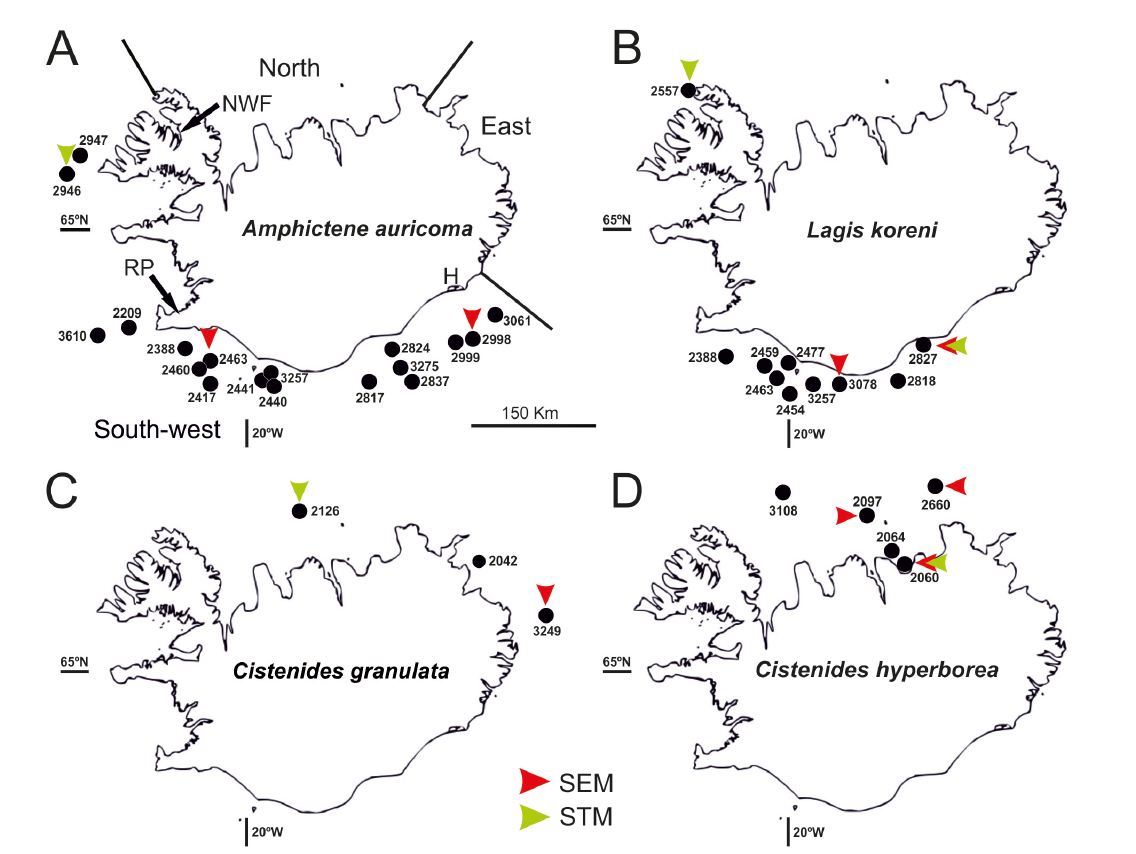
Fig. 1. Maps of Iceland showing distribution of the species of Pectinariidae found in BIOICE samples. A . Amphictene auricoma (O.F. Müller, 1776). B . Lagis koreni Malmgren, 1866. C . Cistenides granulata (Linnaeus, 1767). D . Cistenides hyperborea Malmgren, 1866. The three main coastal sectors around Iceland are shown in A. The specimens photographed and studied under SEM are indicated with green and red arrowheads, respectively. Abbreviations: H = Höfn; NWF = North-western fjords; RP = Reykjanes